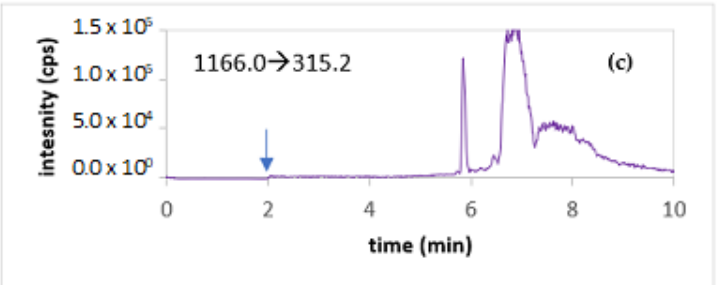
Figure 2. Chromatograms of a solution containing R-insulin, glycated R-insulin, and IS, with the MRM transition of ( a ) R-insulin (0.010 mg/L), ( b ) glycated R-insulin (0.0060 mg/L; concentration estimated from the mass balance), and ( c ) IS (0.060 mg/L) at t = 2 min: switching of the diverter valve to introduce of the mobile phase in the mass spectrometer (blue arrow).